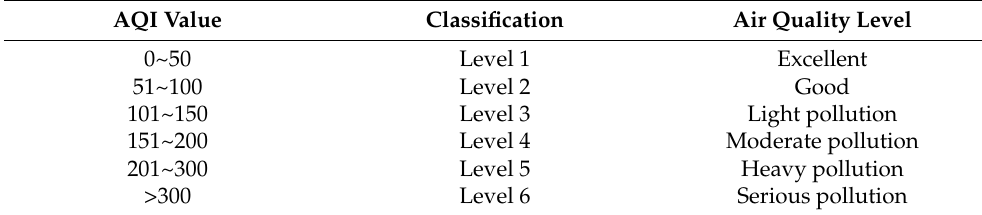
Table 1. Classification standards for the